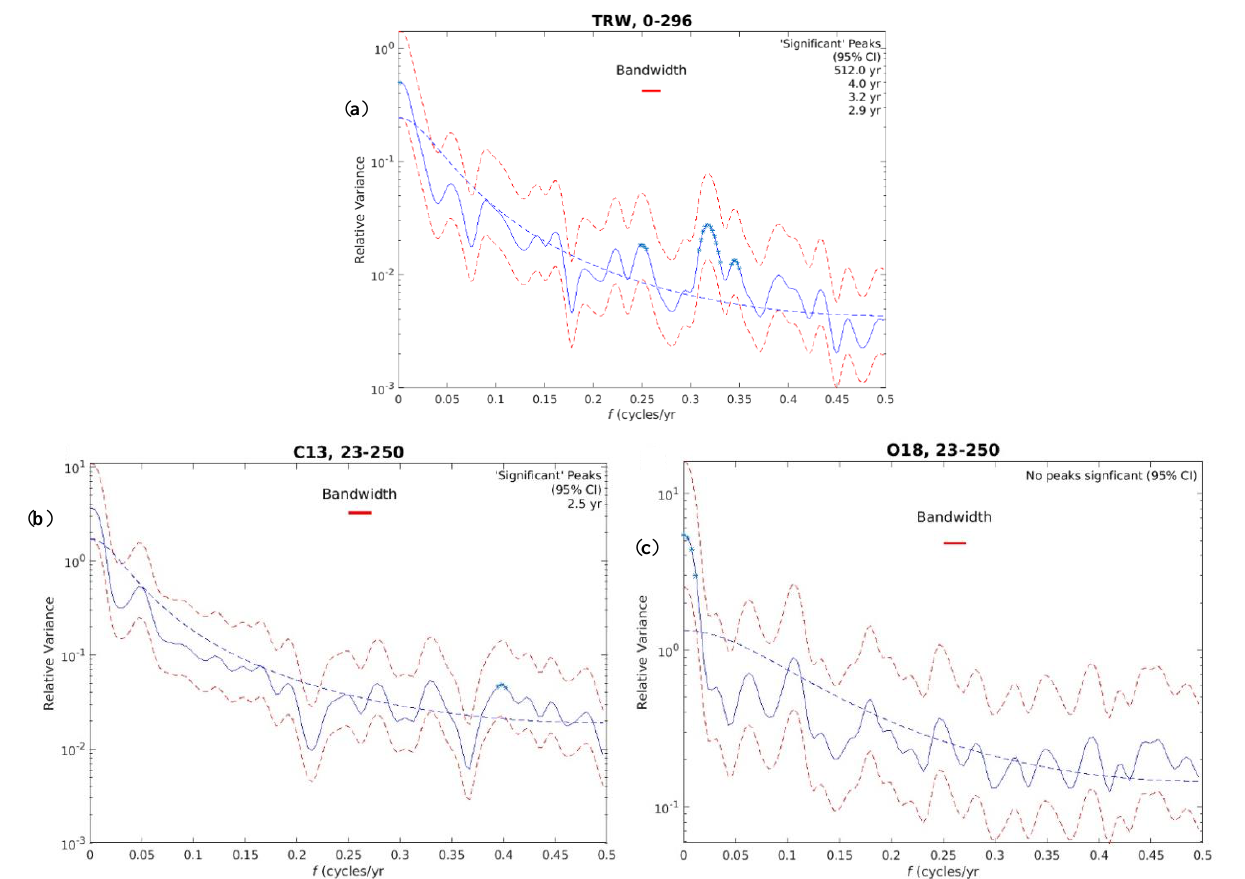
Figure 3. Spectrum of ( a ) ring-width, ( b ) δ 13 C, and ( c ) δ 18 O chronologies of Douglas fir found in the ancient landslide in Oregon Coastal Range. Significant spectral peaks relative to red noise are listed at the top right. Red bar labeled “Bandwidth” describes the effective range of frequencies to which a given spectral estimate applies. Dashed line is the theoretical red-noise spectrum. Analysis by smoothed periodogram method, as described in the Methods.